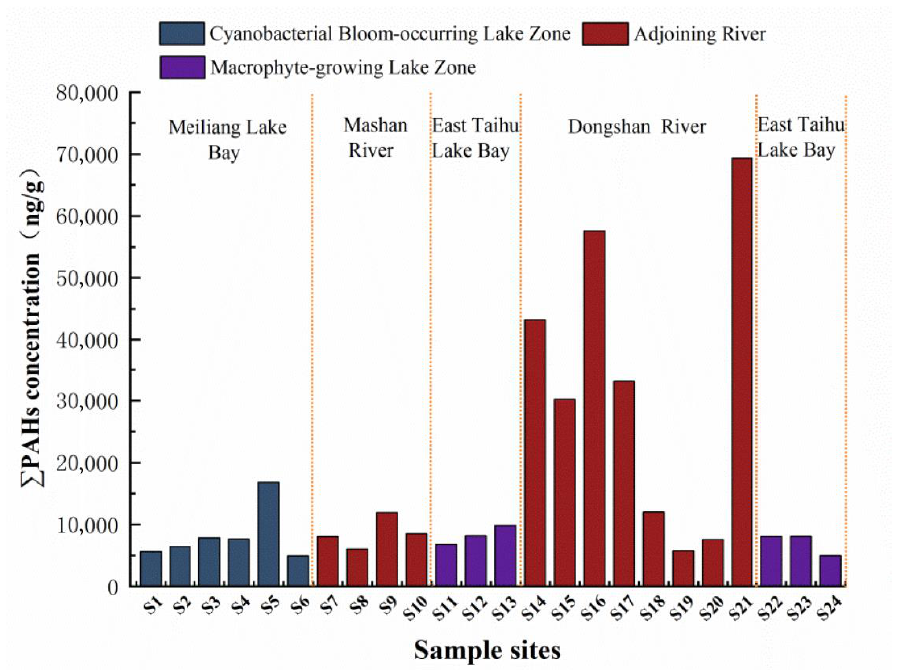
Figure 2. The contents of PAHs in surface sediments of the lake bay and adjoining